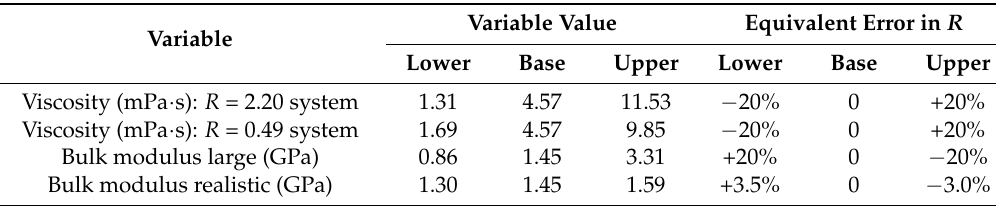
Table 1. Level of uncertainties in fluid